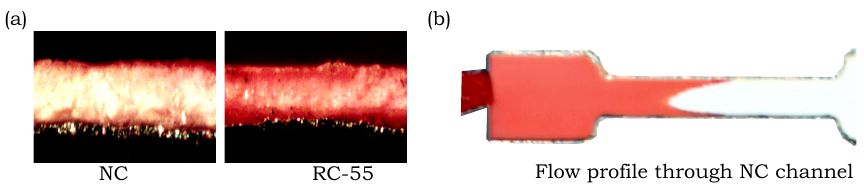
Figure 7. Photographs of the flow of red dye in NC and RC-55. ( a ) Cross-sectional views after red dye flowed through NC and RC-55. ( b ) Overhead view showing the concave flow profile of red dye in NC indicating faster flow along the sides of the